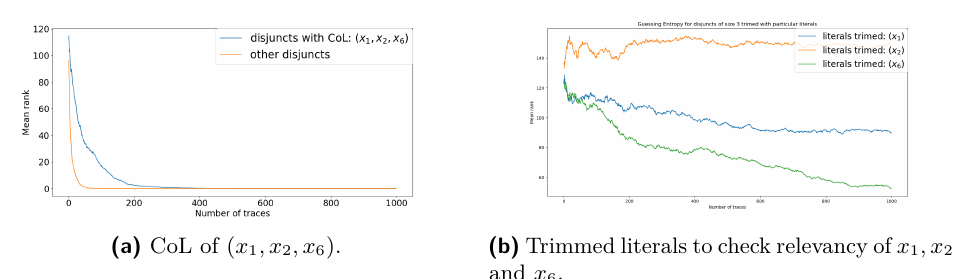
Figure 8: Guessing entropy of TTSCA small on simulated traces of masking order 3 with flaws.